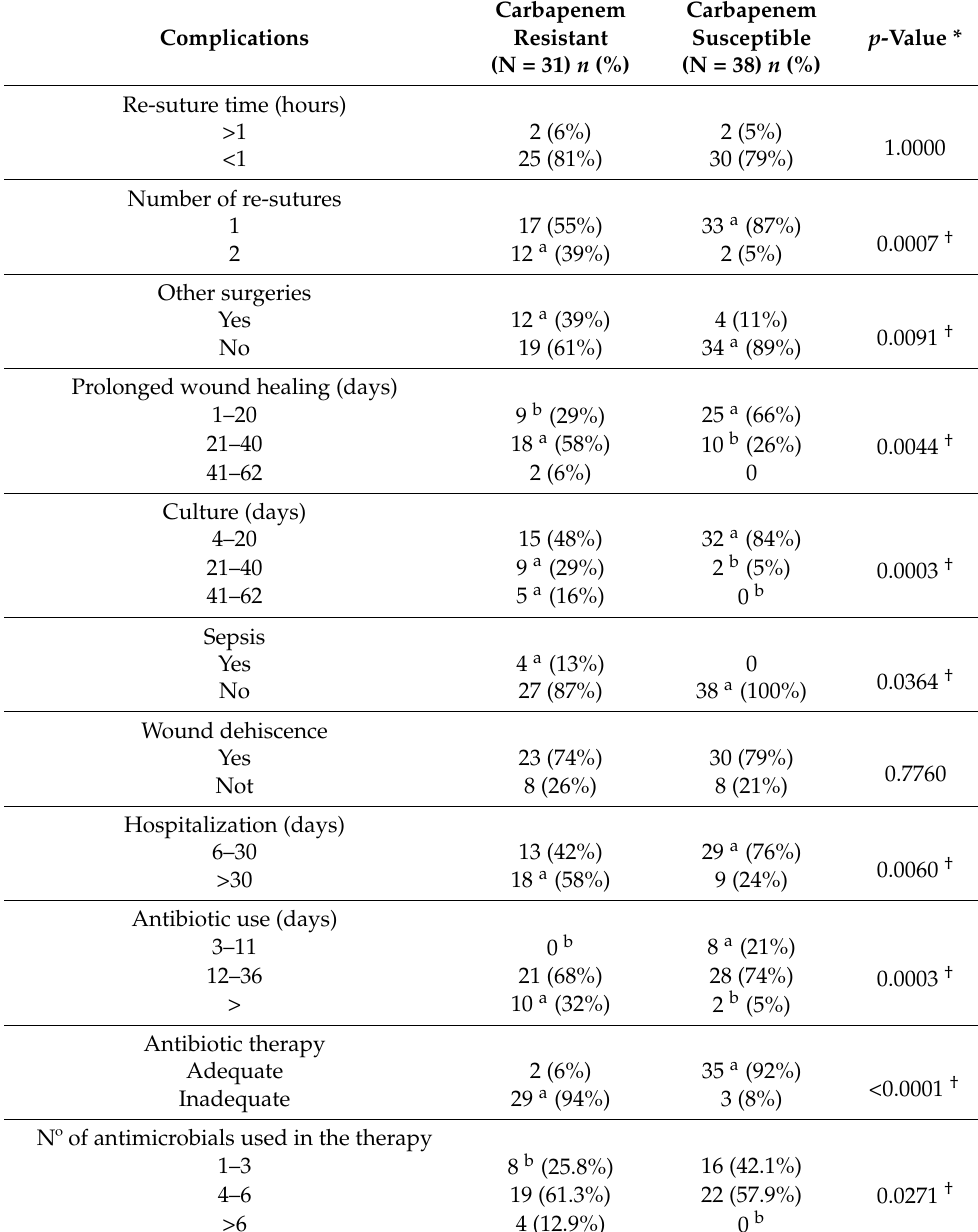
Table 3. Clinical complications developed by women with post-caesarean surgical site infection by carbapenem-susceptible or -resistant Acinetobacter